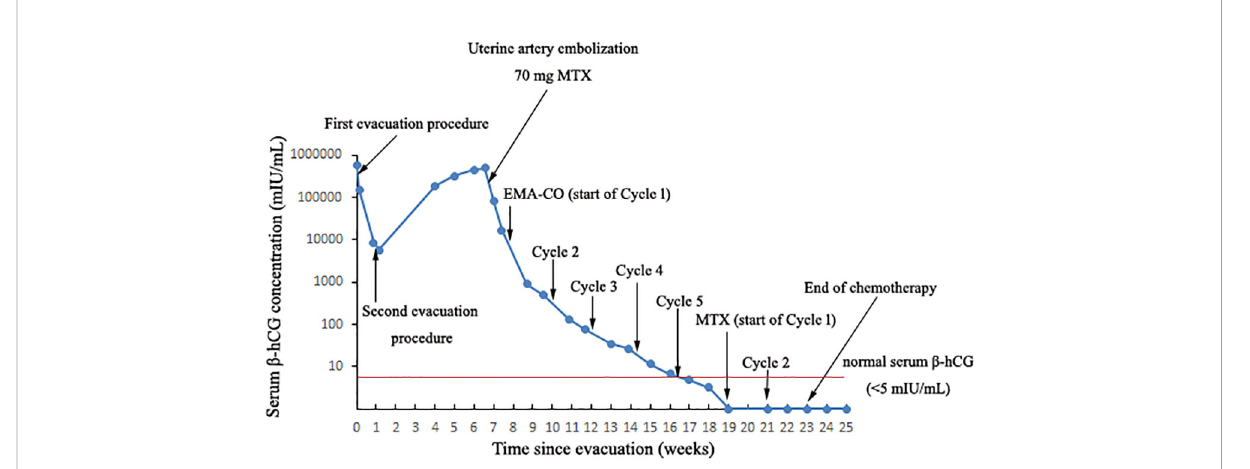
FIGURE 1 The curve showing serum b -hCG during the invasive mole development and in response to the treatment